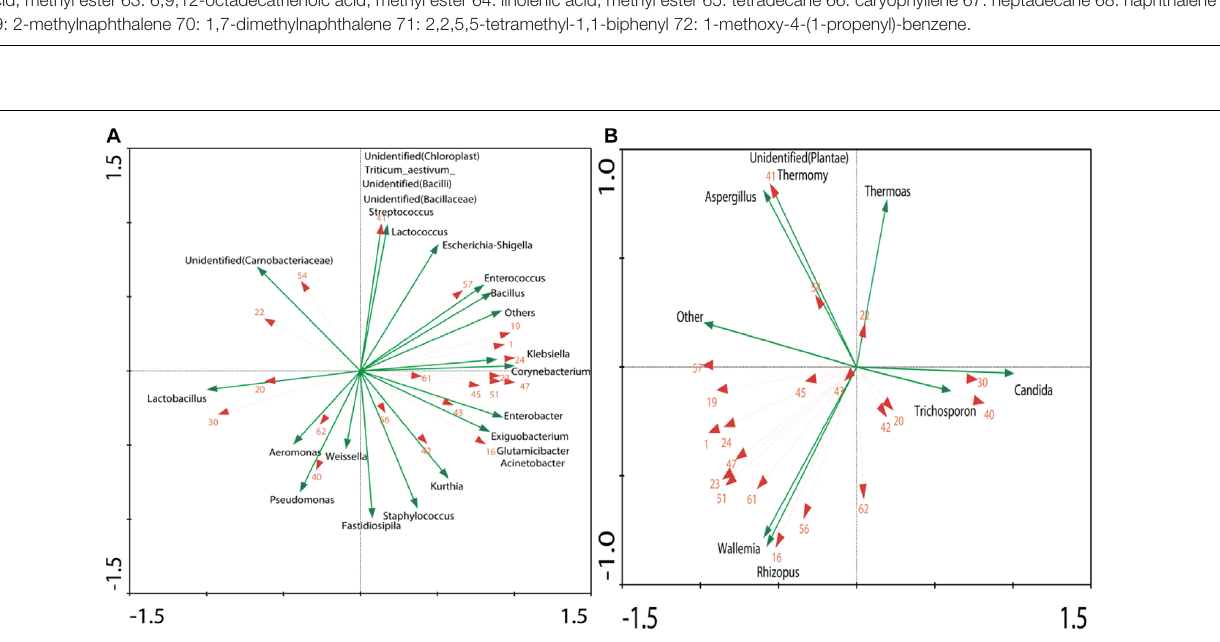
FIGURE 5 | RDA of dominant genera (OTU > 1%) and dominant volatiles (The volatiles were consistent with Figure 4 ): (A) Correlation between volatiles and bacteria genera. (B) Correlation between volatiles and fungi genera.